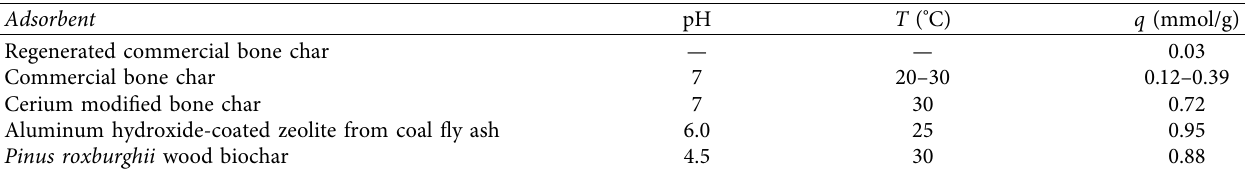
Table 1: Comparison of the fuoride adsorption capacities reported for commercial bone chars and other adsorbents. Adapted from Elvir-Padilla et al.